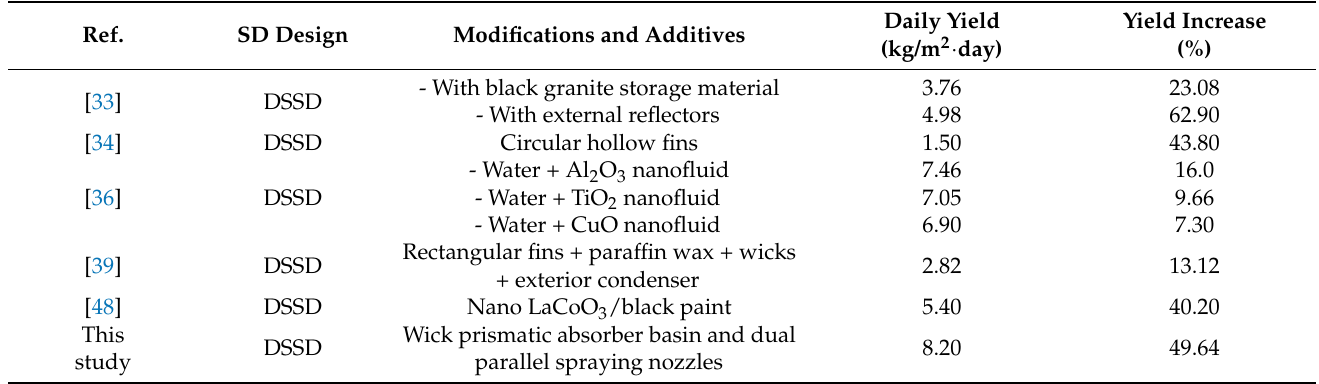
Figure 9. Amelioration percentages in the cumulative distillation yield, energy daily efficiency, and exergy daily efficiency for the modified DSSD-WPB&DPSN compared to the TDSSD. 4. Comparison between the Present Work and Other Previous Studies To identify the significance of the usage of the new design of wick prismatic absorber basin and dual parallel spraying nozzles in enhancing the performance of the DSSD, a comparison between the findings of the present study with those of other relevant works published in double slope solar distillers has been highlighted in Table 2. The anticipated improvements in both water cumulative distillation yields exhibited an efficient perfor- mance with respect to the other related previous works. Table 2. Comparative demonstration between the findings of the present study with those of other relevant works published in DSSDs.